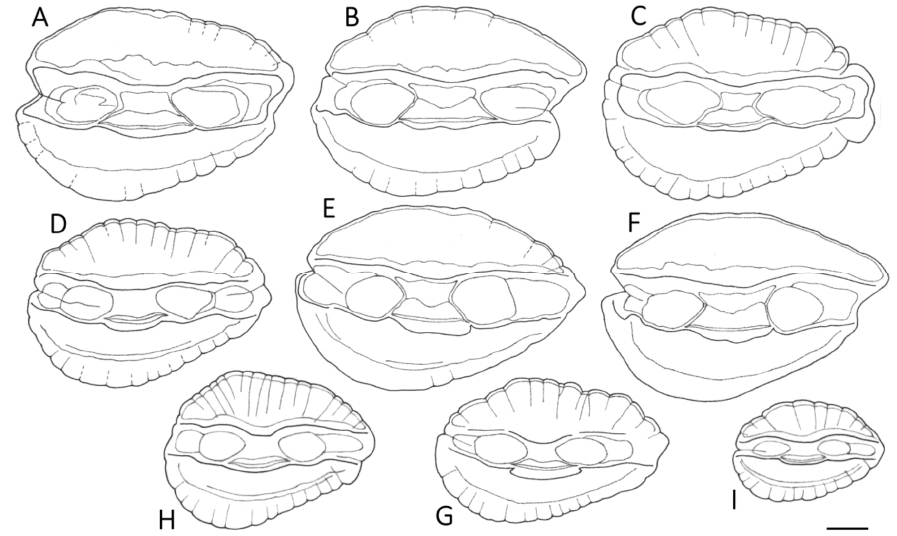
Figure 5. Typical otoliths of Gadiculus argenteus showing moderate morphological variabilities. ( A – G ): Recent otoliths obtained off the Portuguese coast. ( A ) TL 143, Otolith length (OL) 7.56; ( B ) TL 139, OL 7.24; ( C ) TL 145, OL 7.24; ( D ) SL 104, OL 6.43 (mirror image); ( E ) TL 133, OL 7.70; ( F ) TL 133, OL 7.46 (mirror image); ( G ) SL 94, OL 6.19. The otoliths in E and F are from the same specimen showing asymmetry. ( H , I ): Fossil otoliths redrawn from Girone et al. [38], Montalbano Jonico section, Basilicata, Italy, early to mid Pleistocene. Scale bar: 1 mm.